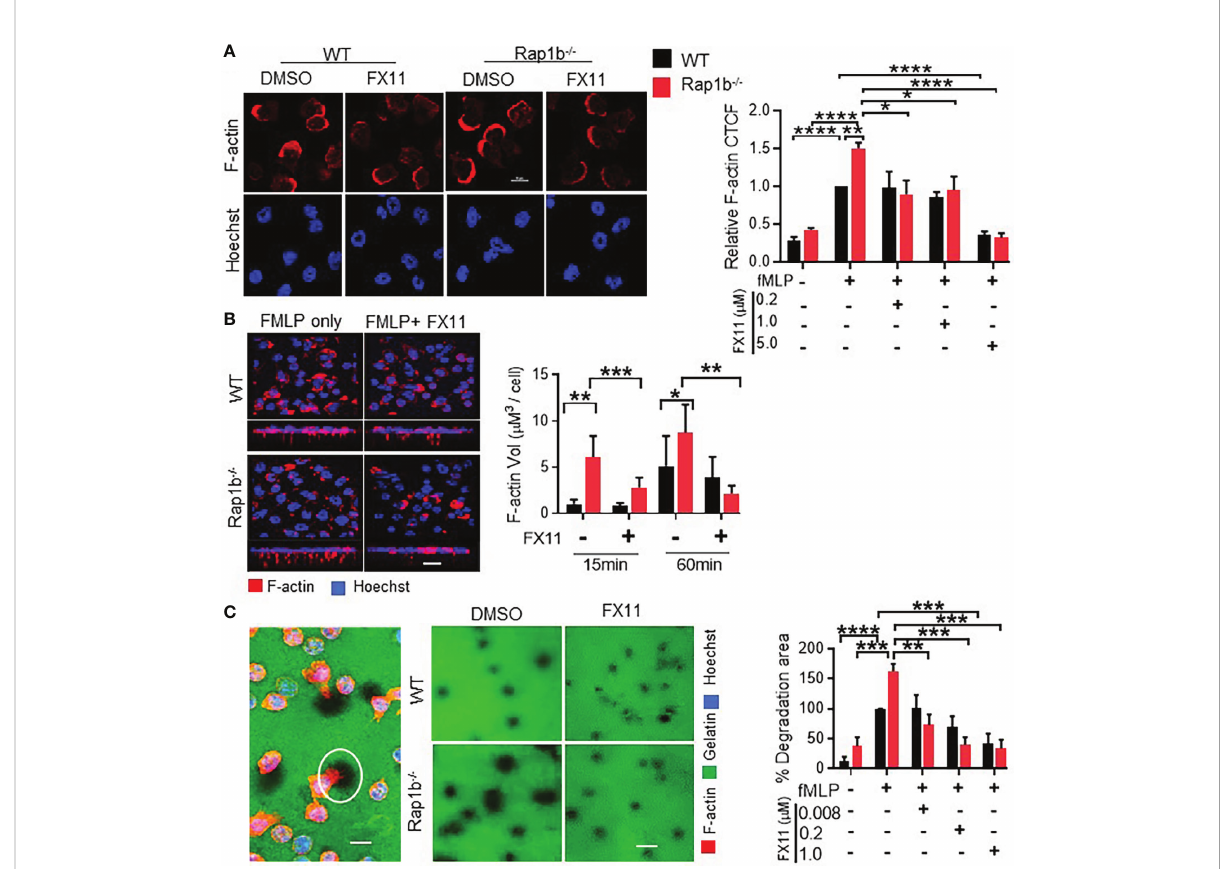
FIGURE 4 Formation of invasive protrusions and extracellular matrix degradation is dependent on neutrophil Ldha. (A) , Effect of Ldha inhibition on neutrophil F-actin polymerization. Representative images of WT and Rap1b -/- neutrophils that were stimulated with fMLP in chambered glass slides for 10 min after pre-incubation with Ldha-I or vehicle control (DMSO) and stained with rhodamine/phalloidin (red) and Hoechst (blue). Bar graphs showing relative F-actin corrected total cell fl uorescence (CTCF) normalized to WT vehicle control taken as 1 (n=4 independent experiments; average of 30 cells/per group/experiment). (B) , Analysis of protrusion formation on 1µm transwell fi lter at 15min in presence or absence of Ldha-I. Z-stack images of Rap1b -/- and WT neutrophils showing formation of invasive protrusions as detected by staining of F-actin (red) and Hoechst (blue). Bar graphs represents volume of F-actin protrusions using Imaris software (n=3 independent experiments. Average of >200 cells/group/experiment). (C) , Extracellular matrix degradation by fMLP stimulated neutrophils. Representative image showing area of degradation as detected by dark areas (white circle) and staining of neutrophils with F-actin (red) and Hoechst (blue) (Right). Representative images showing gelatin degradation by WT and Rap1b -/- neutrophils in the presence or absence of Ldha-I (Left). Bar graphs represent percent degradation area per fi eld relative to WT DMSO group. (n=4 independent experiments; average of 150 cells/condition/experiment). (n=3 independent experiments; average of >10 fi elds under 60x objective/group/experiment). Mean ± SEM; *P < 0.05; **P < 0.001; ***P < 0.0004; ****P<0.0001; using unpaired Student ’ s t test. Scale Bar; (A-C) , =